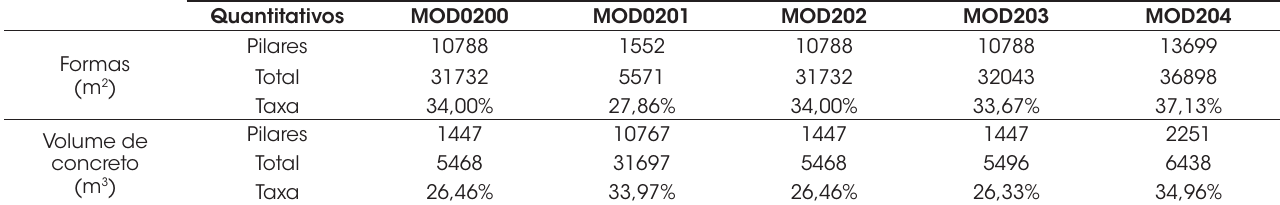
cia para o núcleo rígido. Os resultados deste modelo são apresen - tados na Tabela 5 e Tabela 6 para os parâmetros de